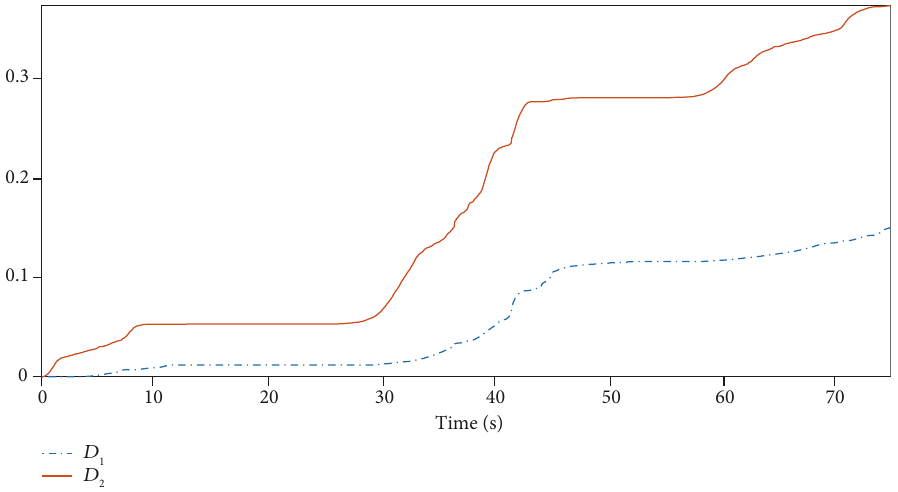
Figure 18: The value changes of the adaptive functions with SMCs.